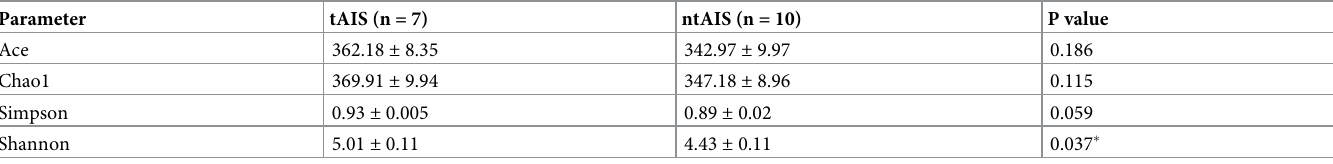
Table 2. Analysis of the α -diversity between the tAIS and ntAIS groups.